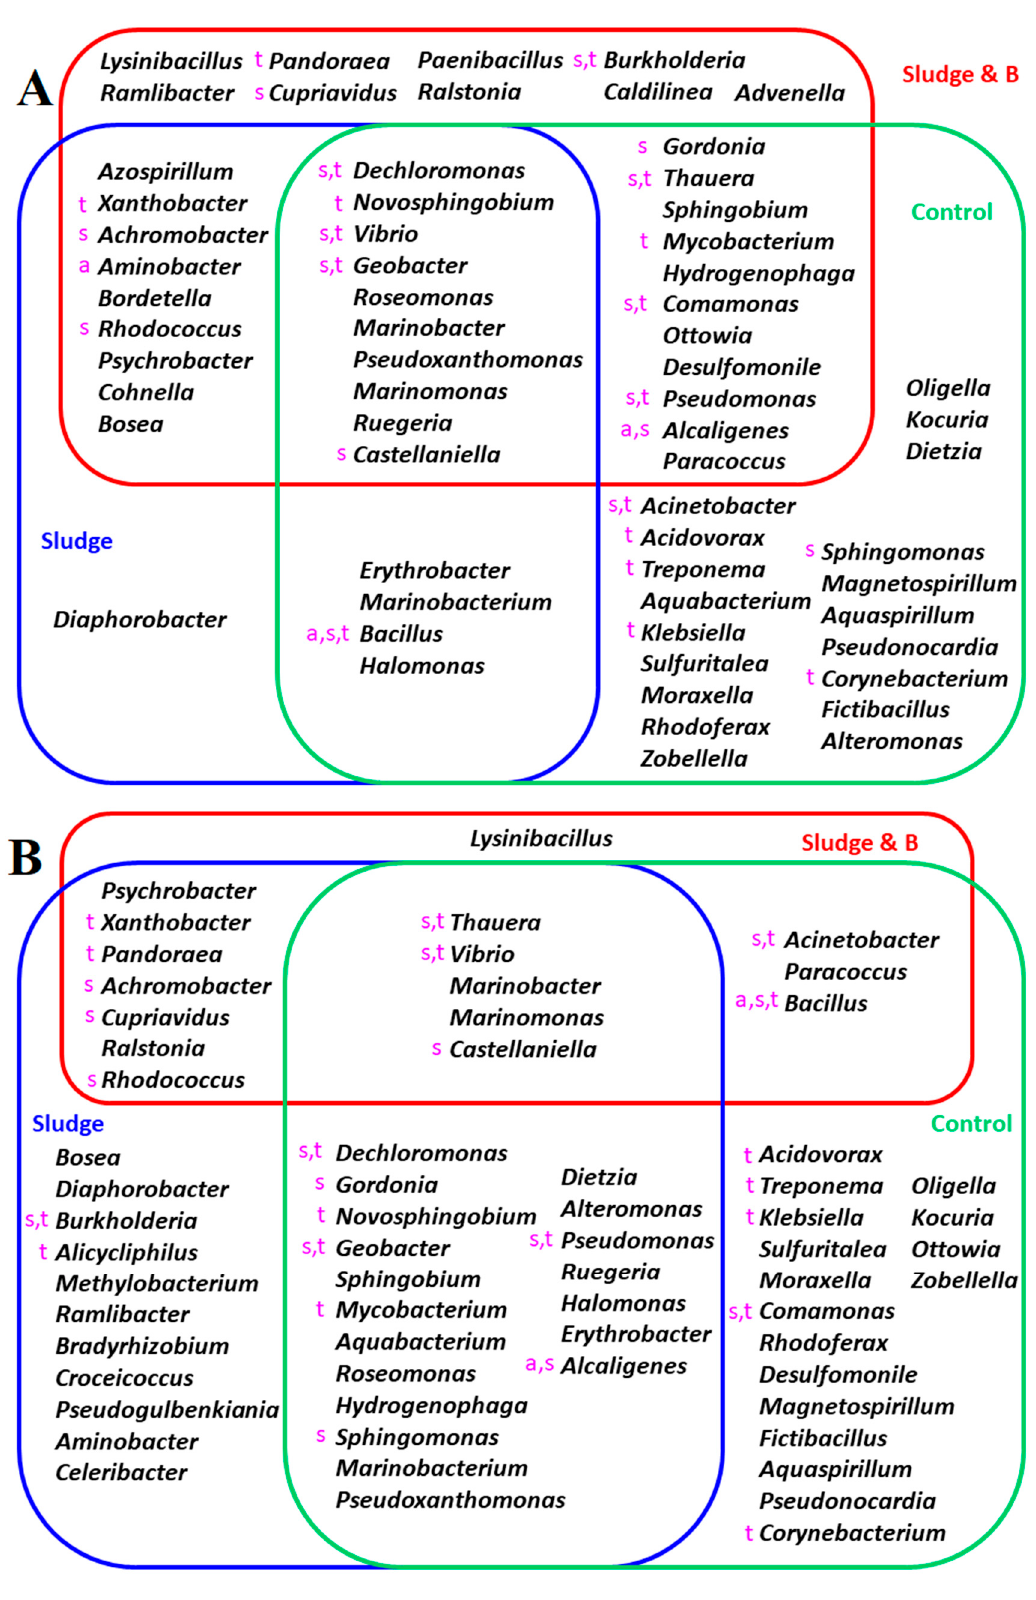
Figure 7. Xenobiotic biodegradation-associated bacteria after the 3rd repeated addition experiment under aerobic ( A ) and anaerobic ( B ) conditions. Control: original sludge. Sludge and B: sludge containing the isolated bacterial strains. a: amoxicillin-degrading bacteria. s: sulfonamide-degrading bacteria. t: tetracycline-degrading bacteria.